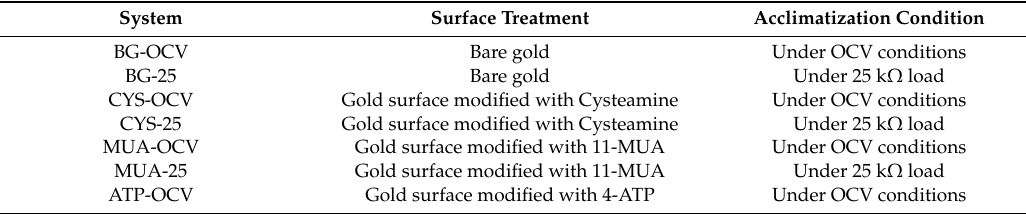
Table 1. µ MFC systems operated in the